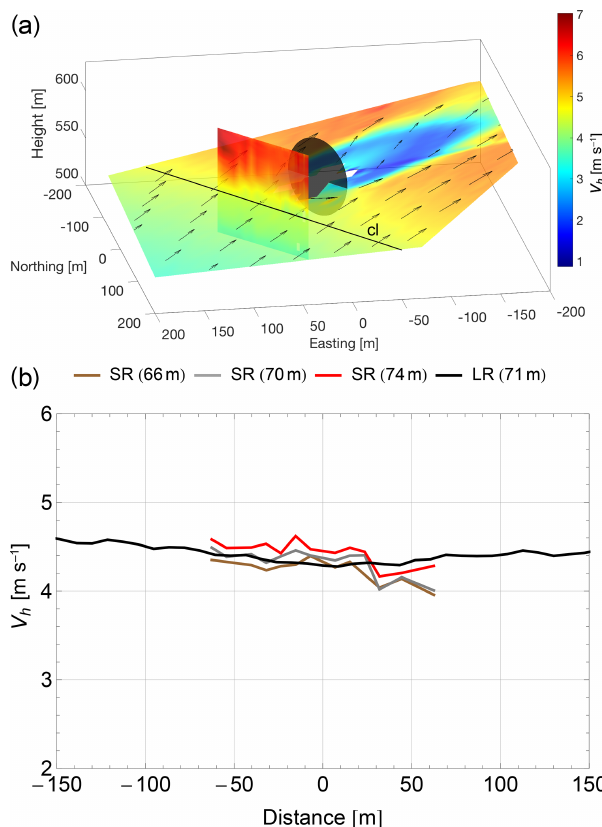
Figure 15. Inflow conditions (10min averaged) measured by a hy- brid WindScanner system on 3 June 2016 from 07:30 to 07:40UTC: (a) three-dimensional representation of two scanned plane (vertical plane – SRWS, horizontal plane – LRWS) with a black line de- noted cl representing the line where the planes intersection coin- cides; (b) the comparison of horizontal wind speed measured by the short-range WindScanner system (lines denoted by SR) and long-range WindScanner system (line denoted by LR) at points distributed along several horizontal lines (lines at 66, 70, 71 and 74ma.g.l.) which are closest to the planes intersection denoted cl in the upper